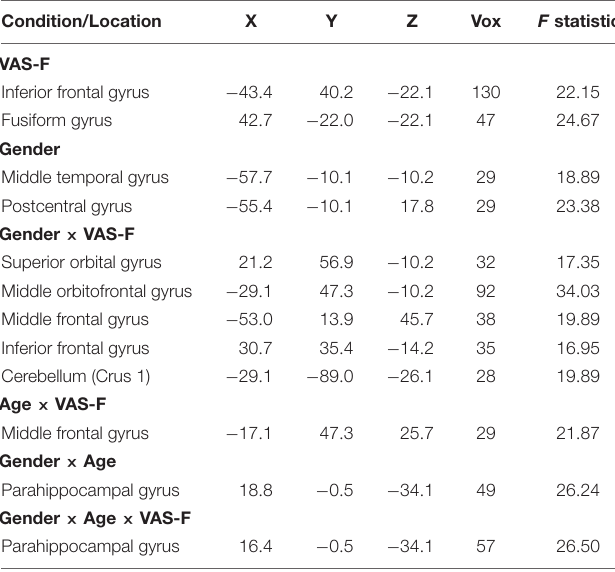
TABLE 2 | The brain areas associated with the main effects of VAS-F and Gender, and with the interactions of Gender × VAS-F, Gender × Age, and Gender × Age × VAS-F.